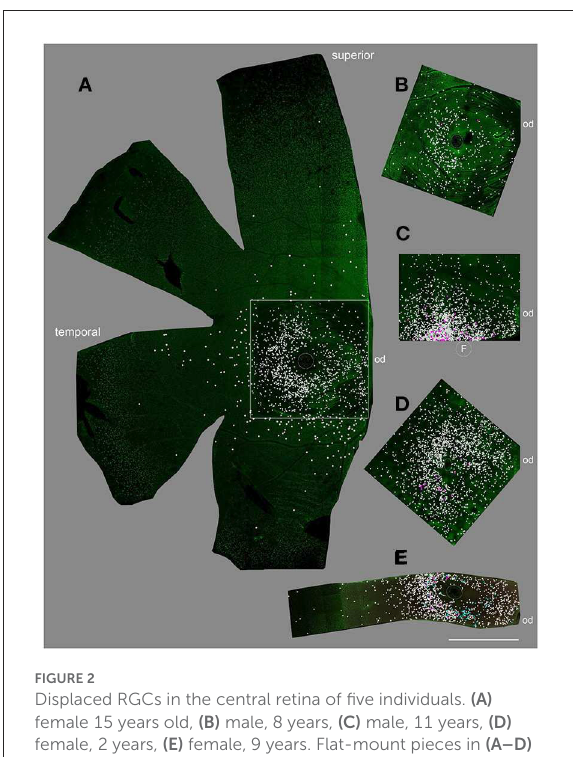
FIGURE2 Displaced RGCs in the central retina of five individuals. (A) female 15 years old, (B) male, 8 years, (C) male, 11 years, (D) female, 2 years, (E) female, 9 years. Flat-mount pieces in (A–D) were labeled with RBPMS, in (E) double labeled with RBPMS and Satb1. White dots mark the position of inner INL displaced RGCs; magenta dots mark outer INL displaced RGCs and cyan dots in (E) mark Satb1 + RGCs. F, fovea; od, optic disc. Scale bar for (A–E) 2mm.